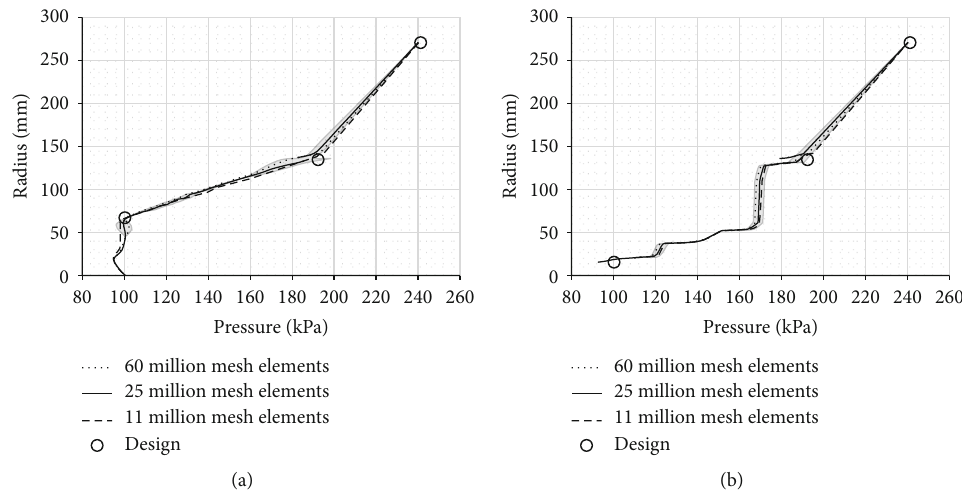
Figure 5: Numerical results of pressure distributions on the (a) shroud and (b) back disk sides with three di ff erent meshes and comparison with the design values. Gray areas present the discretization error. Table 6: Comparison of measured and modeled mass fl ow rate without and with the labyrinth seal. Without seal With seal Point